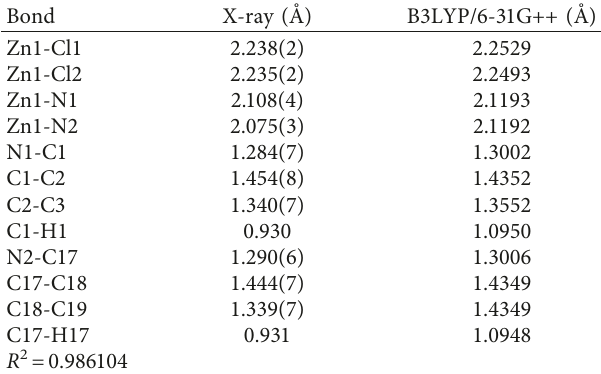
Figure 2: Asymmetric unit of the compound [ZnCl 2 (BS-4-OCH 3 ) 2 ]. Ellipsoids at 30% probability. Hydrogen atoms were omitted for clarity (gray (carbon), red (oxygen), blue (nitrogen), green (chloride), and yellow (zinc)). Table 2: Selected bond lengths (experimental and calculated) for the [ZnCl 2 (BS-4-OCH 3 ) 2 ]